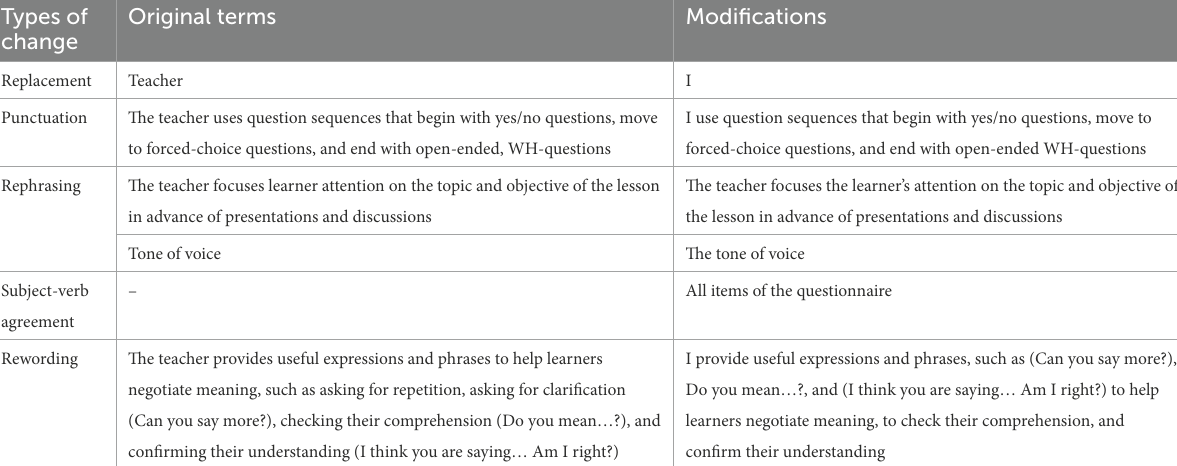
TABLE 2 Experts’ modifications for improving the instrument of the current study.